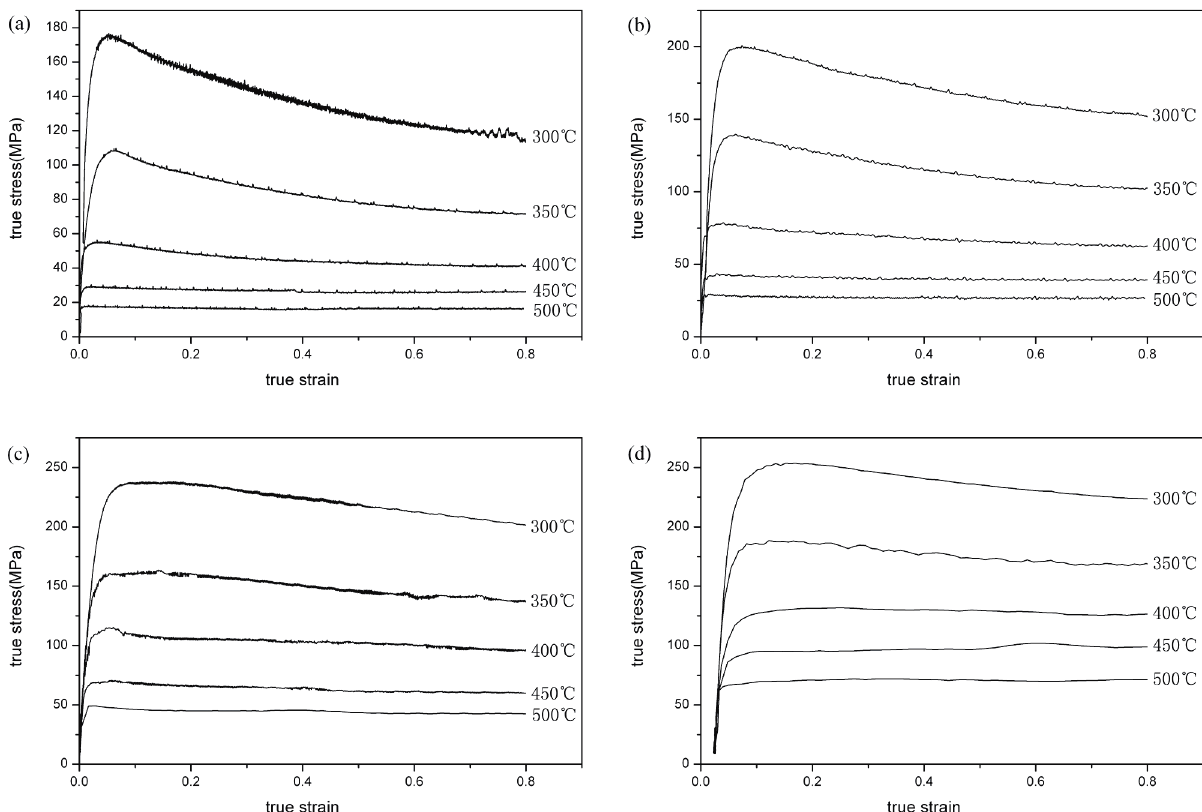
Fig. 1: True stress-true strain curves of 2618-Ti alloy during hot compression deformation: (a) ε = 0.001 s − 1 ; (b) ε = 0.01 s − 1 ; (c) ε = 0.1 s − 1 ; (d) ε = 1.0 s −